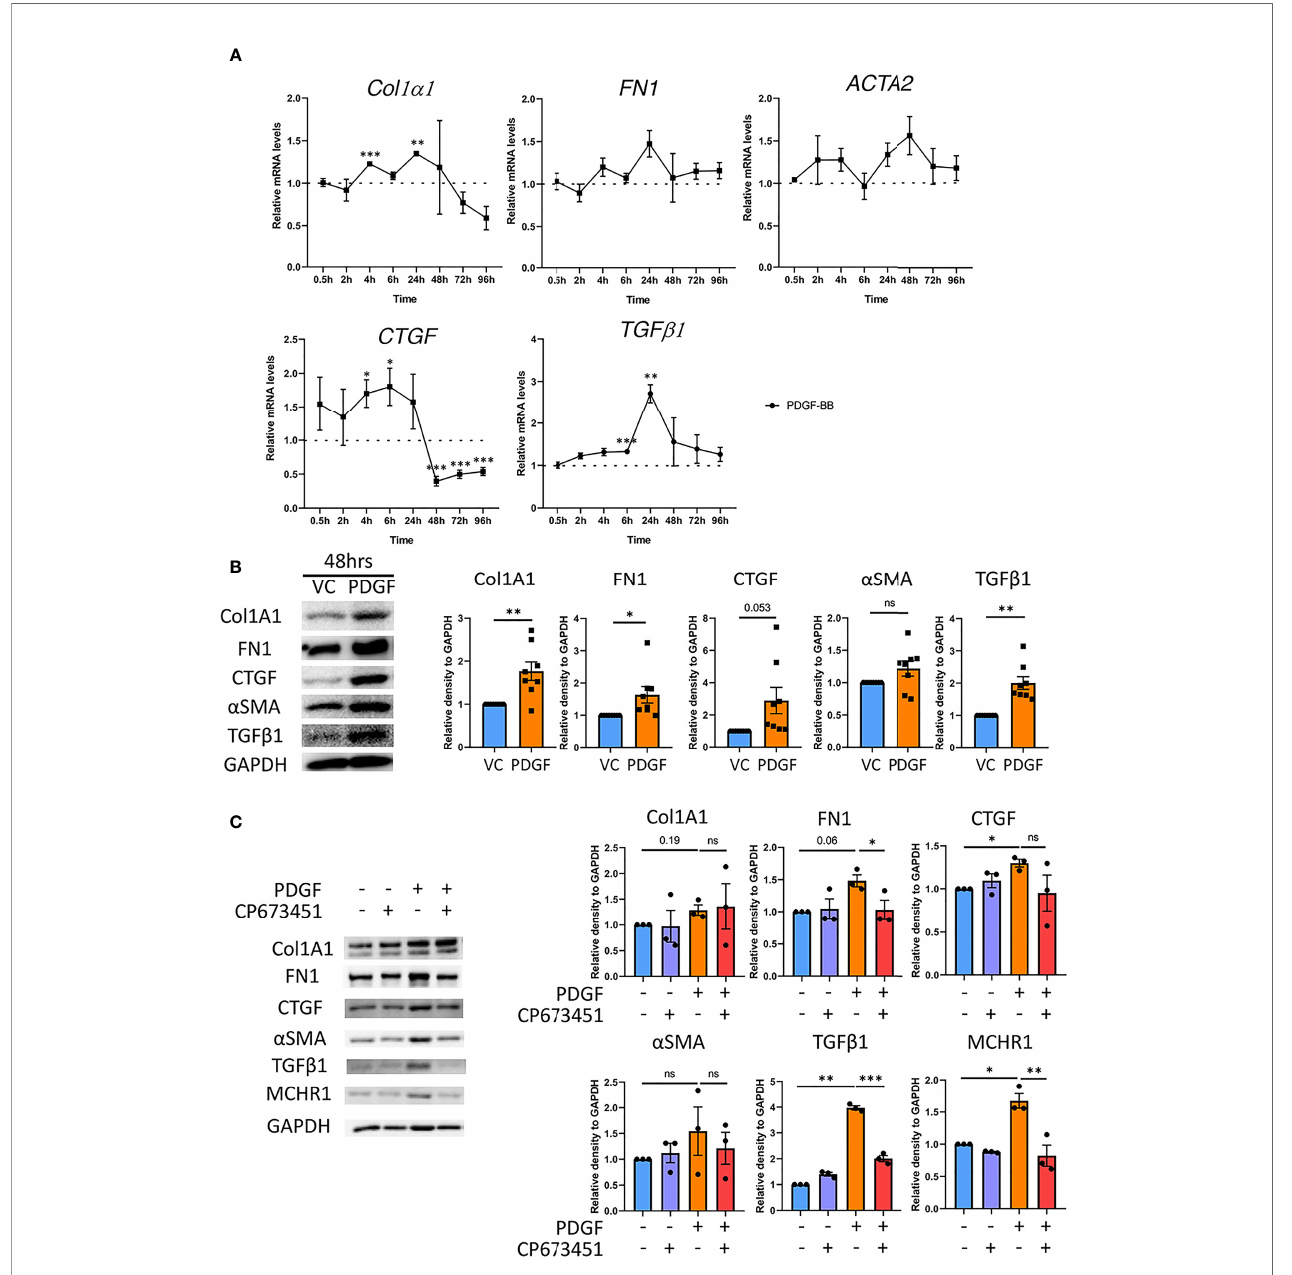
FIGURE 2 | Effect ofPDGF-BB on fi brotic genes in NHDF. (A) The expression levels of fi brotic genes in NHDF treated with PDGF-BB compared to vehicle control at the indicatedtime points (n=3). (B) Quanti fi cation of Col1A1, FN1, CTGF, a SMA andTGF b 1 proteinabundance relative to GAPDH inPDGF-BB-treated NHDF (PDGF,40 ng/ mL) for 48 hrs (n=8).Representativeimmunoblots are shown. (C) Quanti fi cation of Col1A1, FN1, CTGF, a SMA, TGF b 1 and MCHR1 protein abundance relative to GAPDHin NHDF treated with PDGF-BB and PDGF receptor inhibitor(CP-673451) (n=3).Representative immunoblots are shown. NHDFwere treated with 10 nM of CP-673451 1 hr prior to PDGF-BB (40ng/ml for 48 hrs).Ethanol was used as vehiclecontrol. *P < 0.05, **P < 0.01, ***P < 0.001, ns, not signi fi cant, error bars=